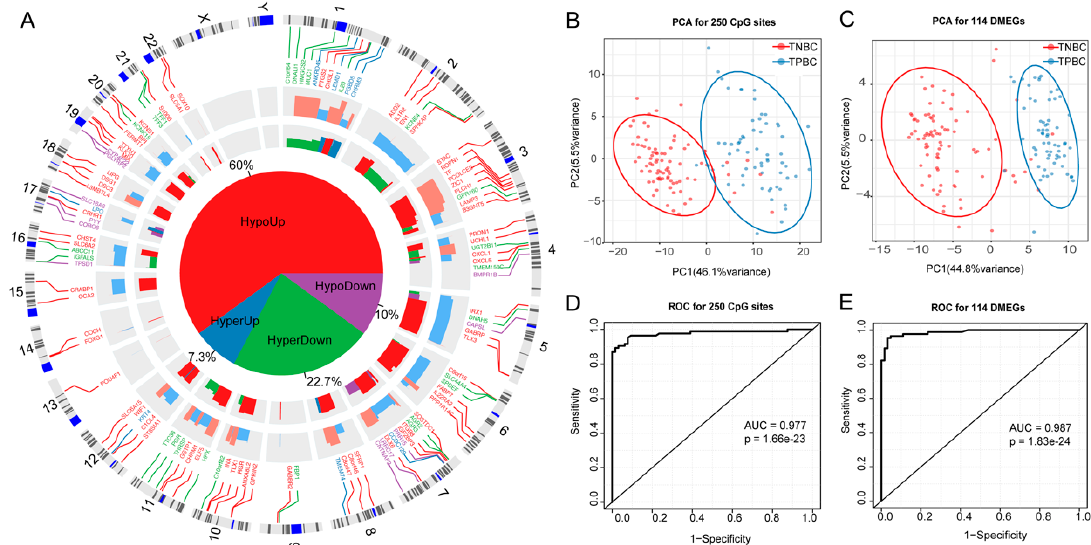
Figure 4. Prediction of TNBCs by DNA methylation and gene expression profiles. ( A ) Circos plot showing genome ‐ wide locations of 114 DMEGs and their methylation and expression distribution.